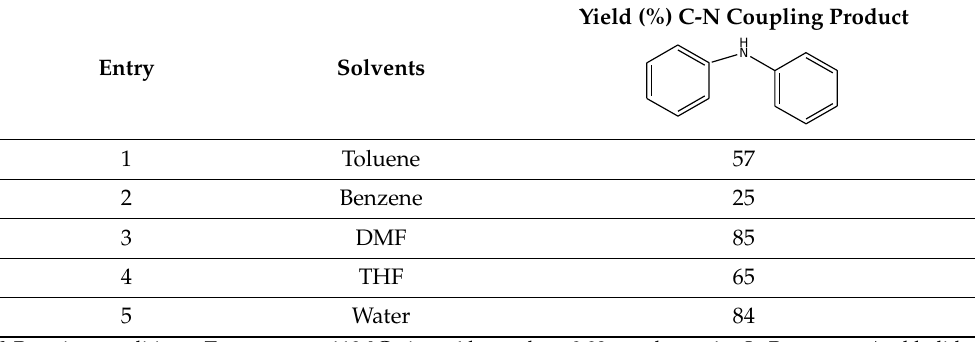
Table 3. The effect of different solvents on the yield for the C-N Ullmann coupling reaction using 5